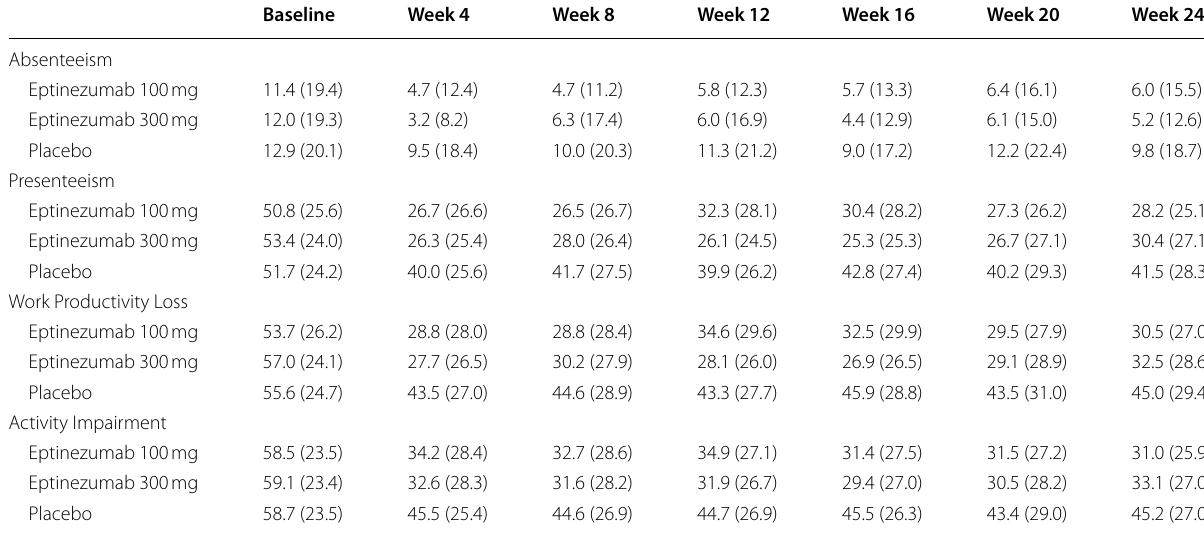
Table 1 Mean (SD) WPAI:M Subscores, by Treatment and Week